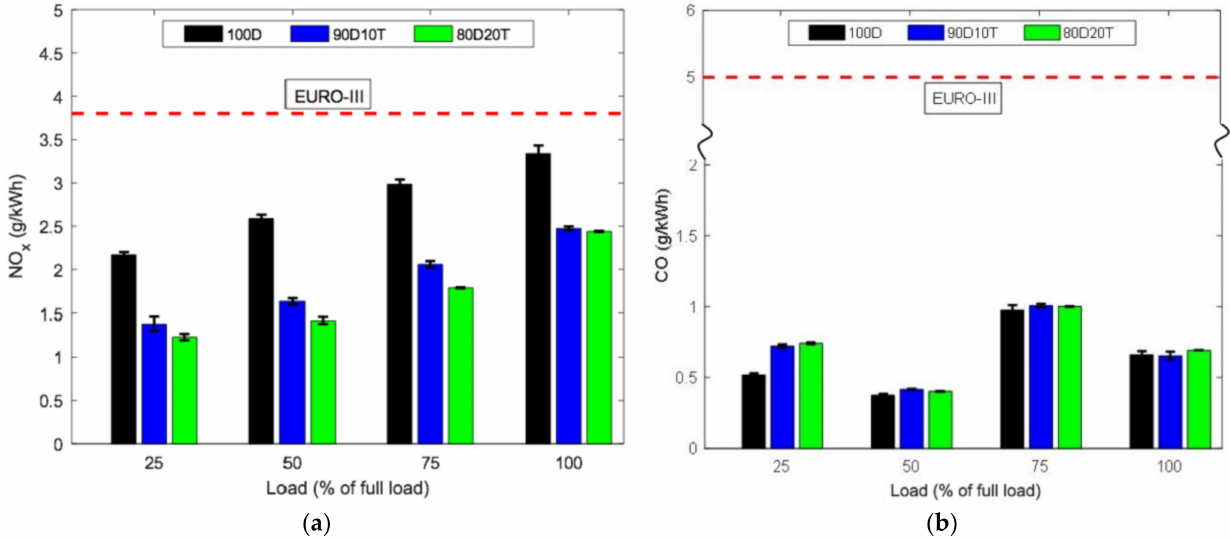
Figure 8. Brake-specific NOx ( a ) and CO ( b ) emission with TPO. (100D—100% diesel; 90D10T—90% diesel + 10% TPO; 80D20T—80% diesel + 20%